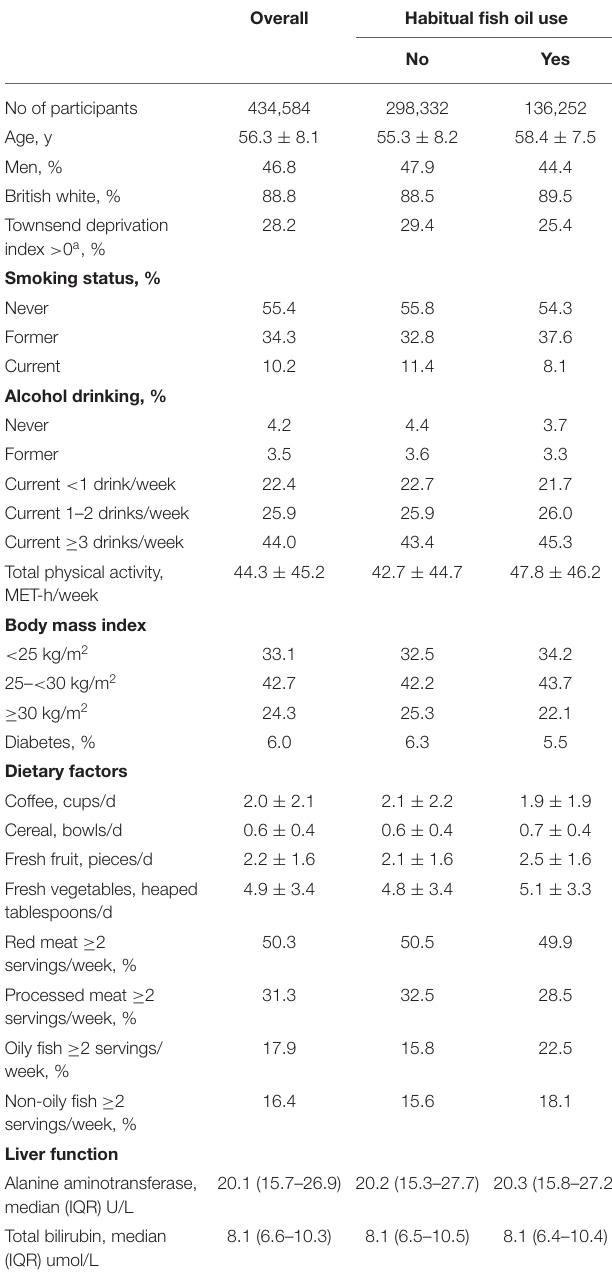
TABLE 1 | Baseline participant characteristics according to fish oil